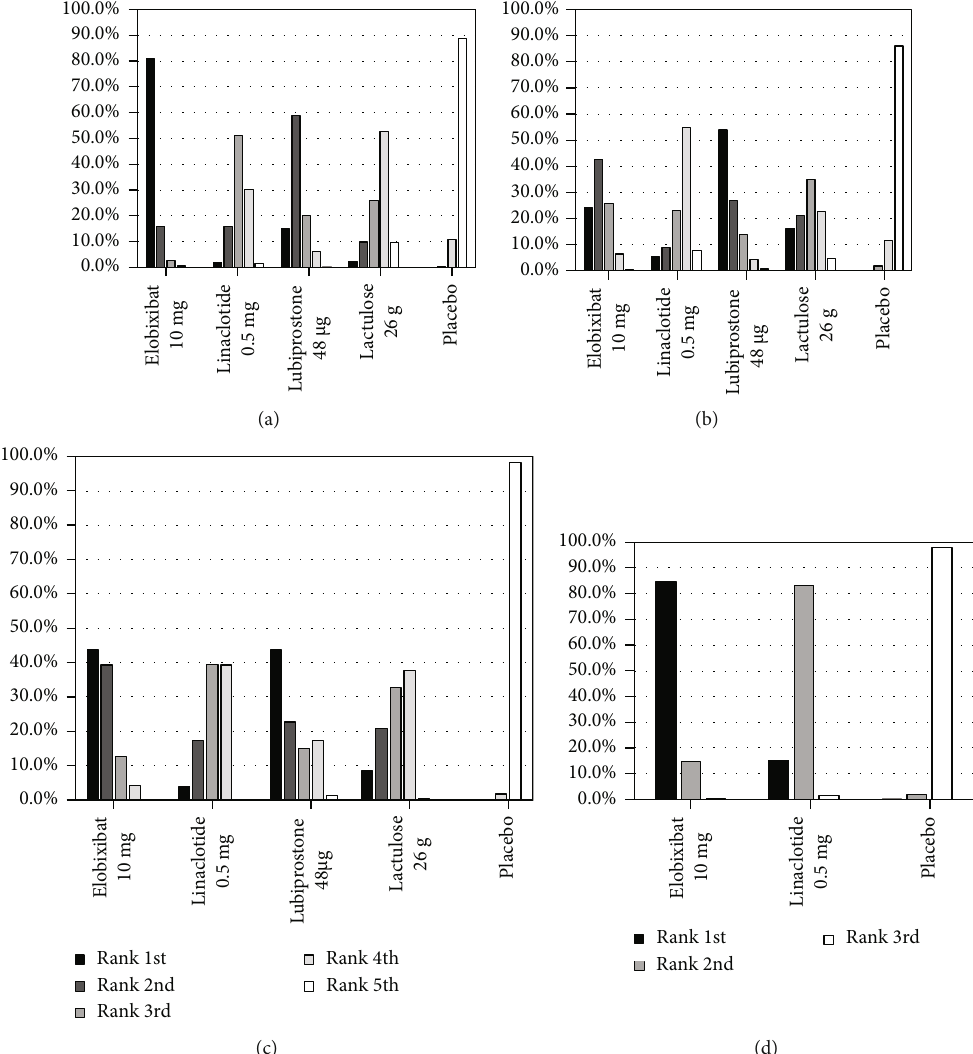
Figure 6: Rank probabilities of typical doses of subject medications: (a) change in weekly SBMs; (b) proportion of patients with SBM within 24 hours; (c) time to fi rst SBMs; (d) change in weekly CSBMs. CSBM: complete spontaneous bowel movement; SBM: spontaneous bowel